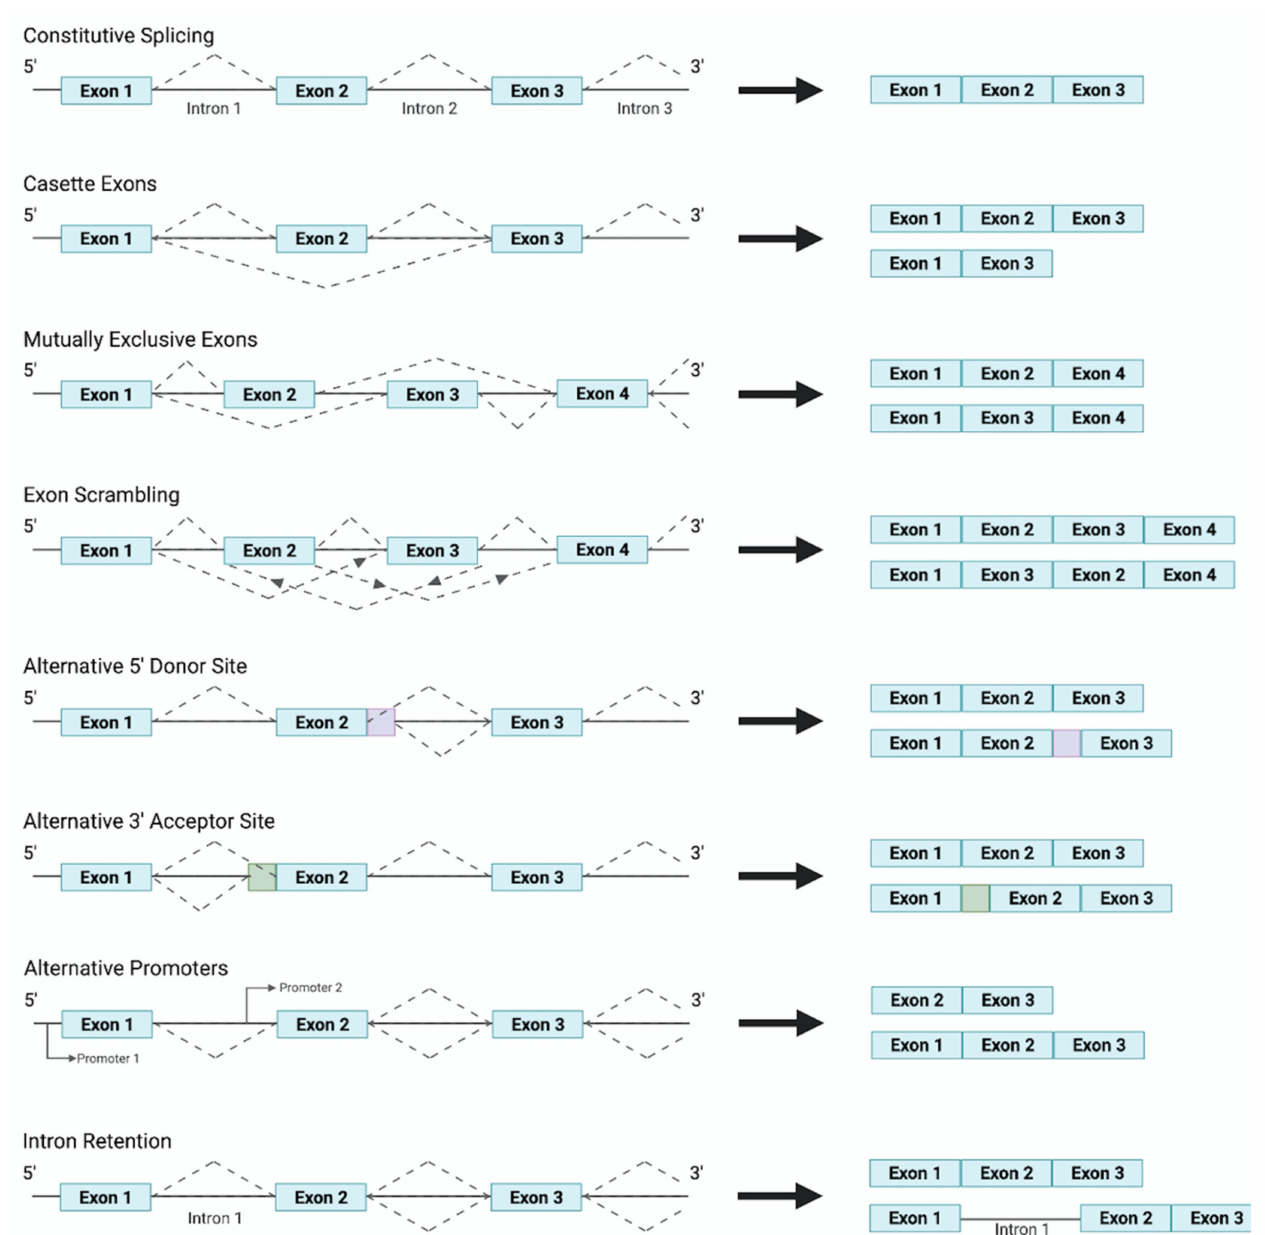
Figure 1. A schematic overview of the commonly observed splicing patterns responsible for the production of distinct transcripts from a singular